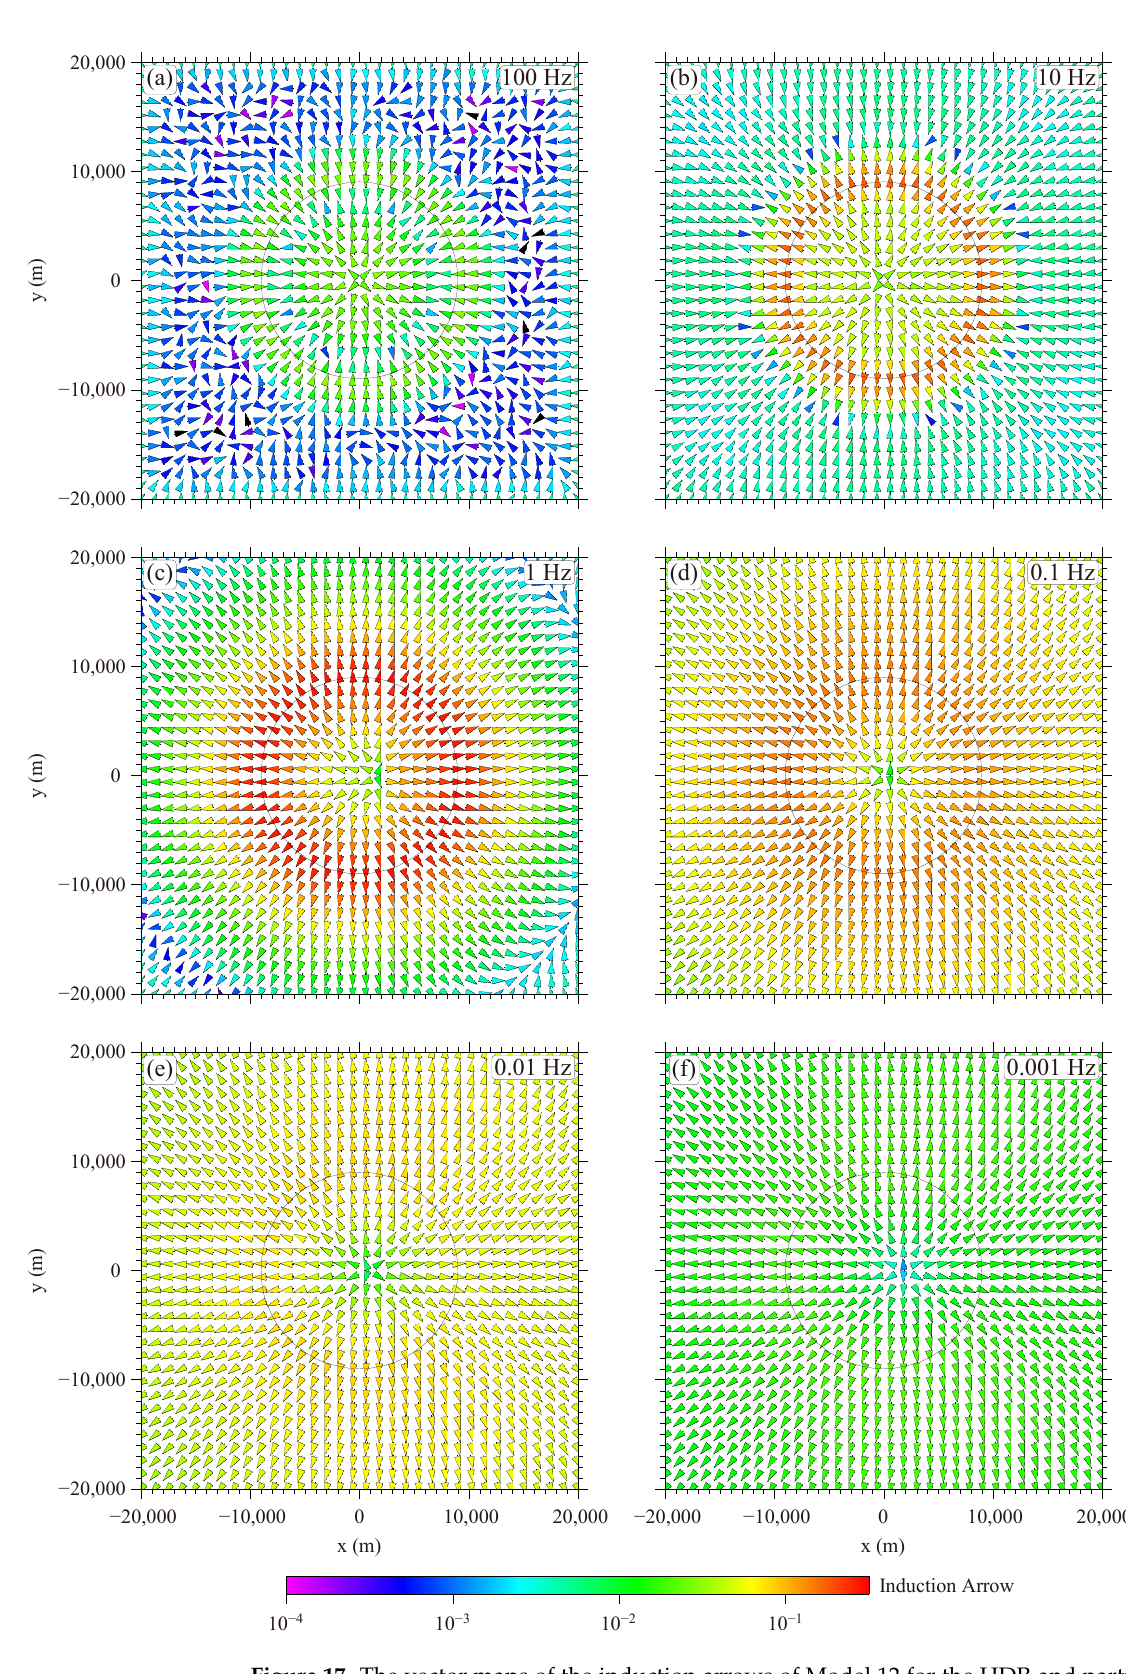
Figure 17. The vector maps of the induction arrows of Model 12 for the HDR and partial melting system, as shown in Figure 13. ( a – f ) are for the frequencies of 100, 10, 1, 0.1, 0.01, and 0.001 Hz, respectively. The black circles indicate the projection of the clay cap on the x - y plane.